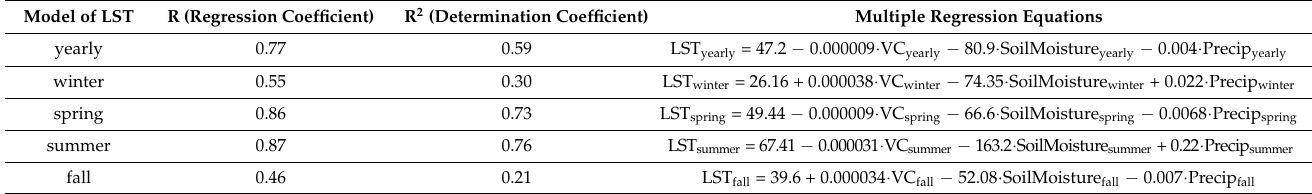
Table 3. The yearly and seasonal multiple regression relationships between country-wide means of LST, precipitation, soil moisture, and vegetation coverage in Afghanistan in the period